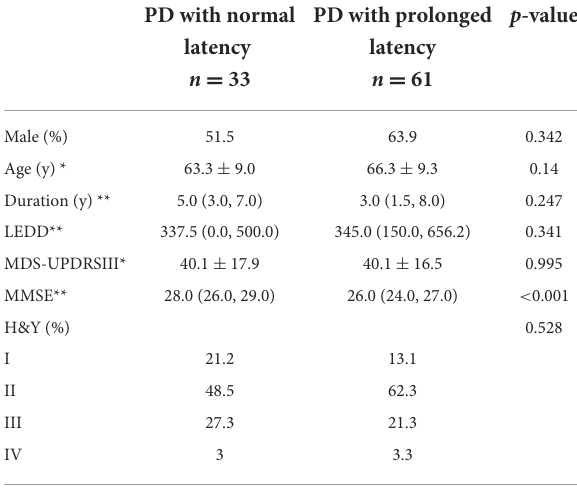
* represented as mean ± standard deviations, ** represented as median (IQR). PD, Parkinson’s disease; MMSE, minimal mental state examination; LEDD, levodopa equivalent daily dose; H&Y, Hoehn and Yahr; MDS-UPDRS, Movement Disorder Society unified Parkinson’s disease rating scale (version 3.0). P < 0.05 was considered